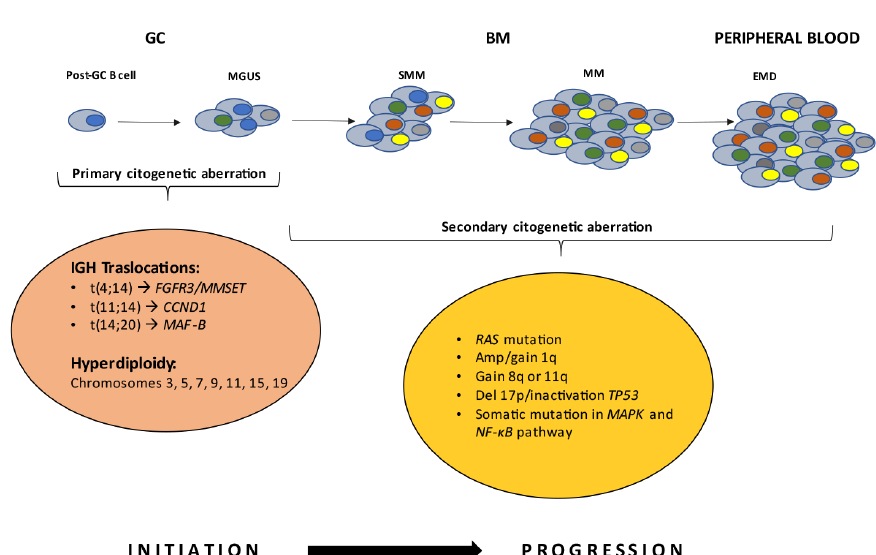
Figure 1. The basis of neoplastic transformation and development of MM are mutational events at the PC level. Early genetic events drive the MGUS stage. Further mutations induce deregulations in the PCs, leading to the transition to the SMM and MM stages. The latter steps are characterized by the proliferation of monoclonal PCs in the BM microenvironment. In rare cases, it can evolve into extramedullary disease (EMD). FGFR3 : fibroblast growth factor receptor 3; MMSET : multiple myeloma SET domain; CCND1 : cyclin D1; MAF-B : musculoaponeurotic fibrosarcoma oncogene homolog B; Amp: amplification; Del 17p: deletion 17p; TP53 : tumor protein